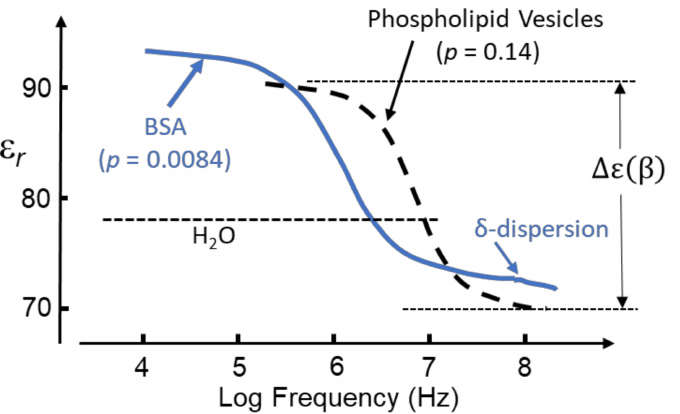
Figure 5. The β -dispersion exhibited by a 0.18 mM (i.e., p = 0.0084) BSA solution [40] is shown, together with that of a suspension of phospholipid vesicles (radius 13.5 nm, volume fraction p = 0.14) [42]. The δ -dispersion is associated with the protein hydration sheath [41,44,45]. Positive DEP can be expected for both particle types in the frequency range where their relative permittivity, ε r , exceeds that (~78) of pure bulk